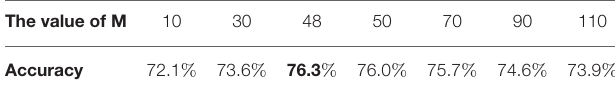
TABLE 8 | The classification accuracy with different